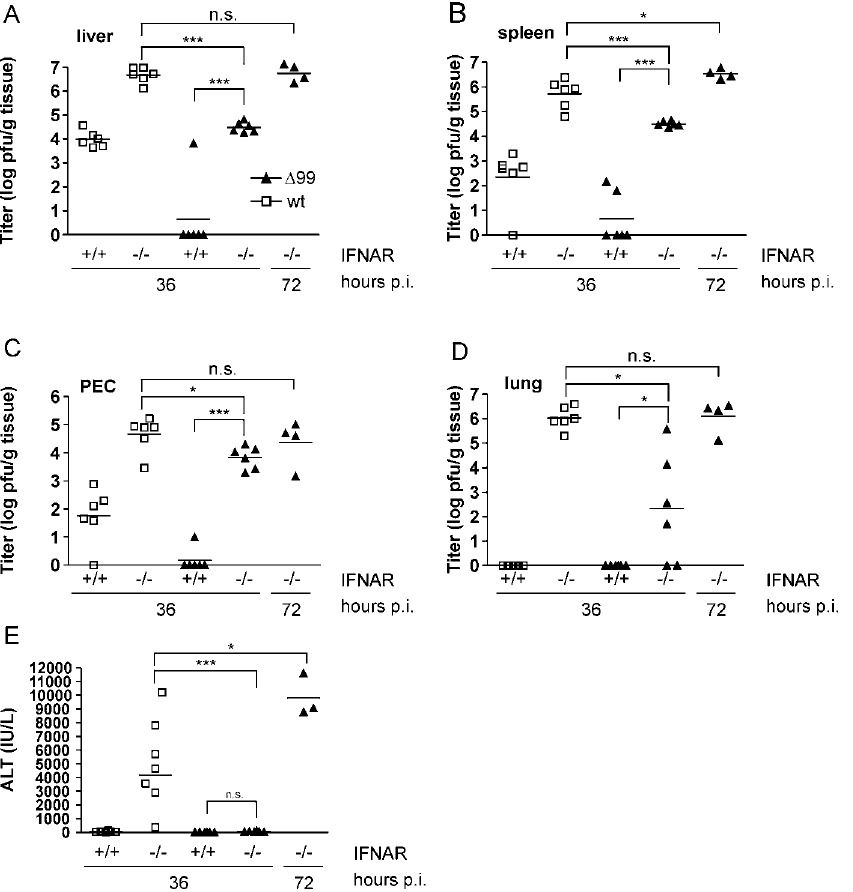
Figure 5. nsp1-Dependent Attenuation Is Reversed in IFNAR (cid:3) / (cid:3) Mice IFNAR (cid:3) / (cid:3) or wild-type 129Sv mice were infected intraperitoneally with 500 pfu of MHV-nsp1 D 99 or MHV-A59. At the indicated time points p.i., viral titers in livers (A), spleens (B), peritoneal exudates cells (PEC) (C), and lungs (D) were determined. (E) ALT values in serum were measured at the indicated time points p.i. Horizontal lines represent means with values from individual mice shown as open squares (MHV-A59) or filled triangles (MHV-nsp1 D 99) from two experiments with a total of three to six mice. Statistical analysis was performed using Student’s t -test ( *** , p , 0.001; * , p , 0.05; n.s., p . 0.05).